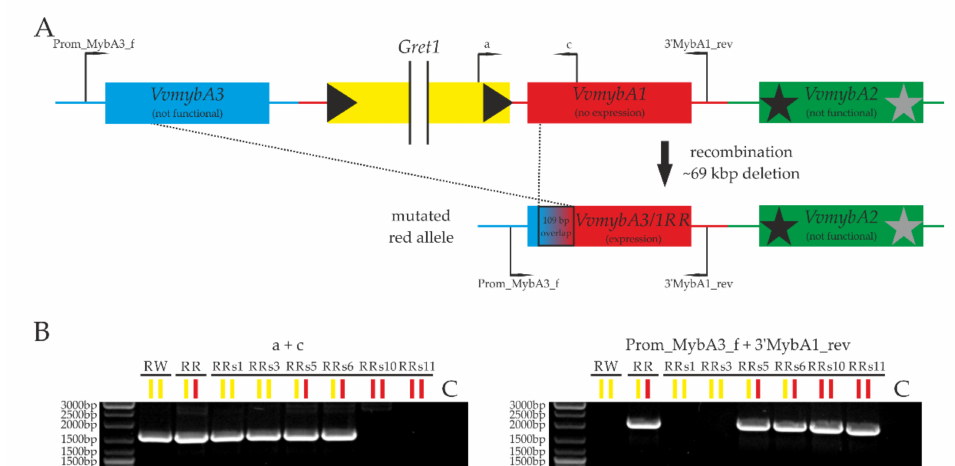
Figure 2. The unique mutation of ‘Riesling Rot’ at the grapevine berry color locus on chromosome 2. ( A ) Schematic overview of the two ‘Riesling Rot’ haplophases at the BCL based on BAC clone sequencing. Primer binding sites used in ( B ) are indicated. Dotted lines represent the putative recombination site. ( B ) PCR results for ‘Riesling Weiss’, ‘Riesling Rot’, and the ‘Riesling Rot’ selfing line RRs. Colored bars represent the haplotype constitution at the berry color locus (yellow = white allele, red = red allele). RW = ‘Riesling Weiss’; RR = ‘Riesling Rot’; C = no template